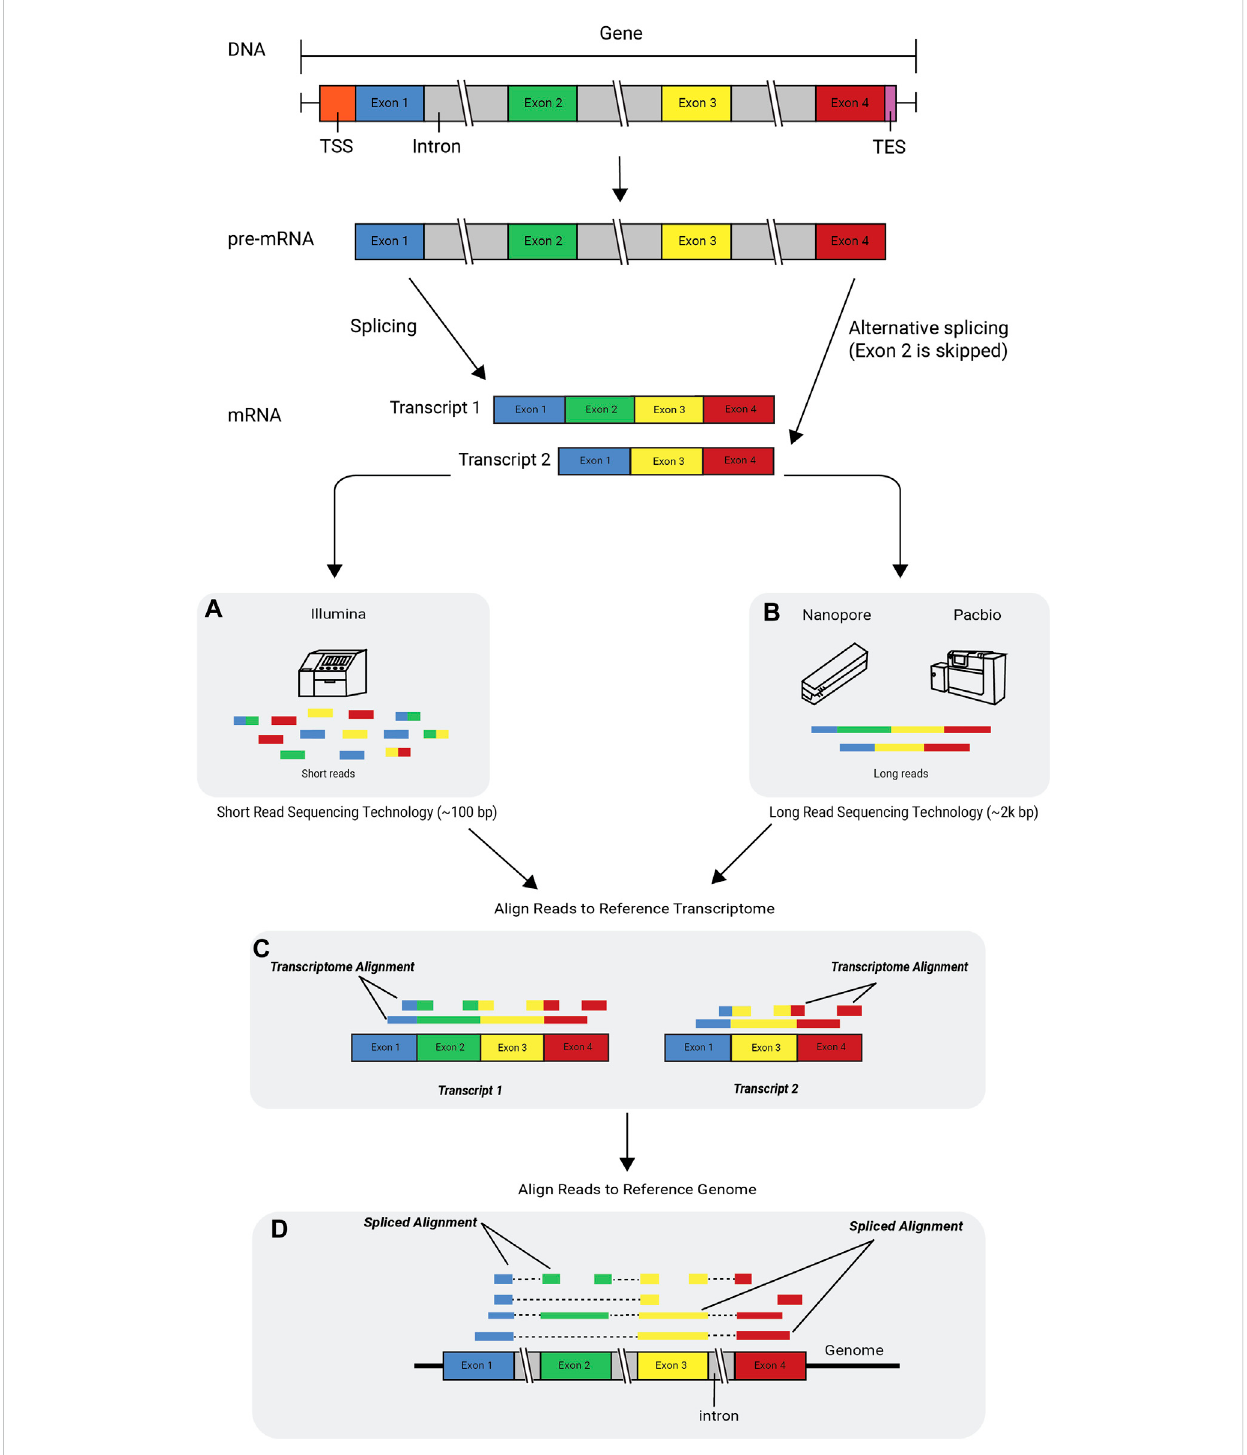
FIGURE 2 Alternativesplicing andRNA-seqtechnologies. The fl ow of geneticinformationbeginswith DNA, whichconsistsof introns and exons. DNA is transcribed into pre-mRNA and then further processed into mature mRNA by splicing out the introns and leaving the exons glued together. The mRNA is then translated into a protein. Transcripts with different arrangements of exons can be formed in a process called alternative splicing or exon skipping. An RNA-seq read is a short sequence sampled from a transcript. Reads are generated using sequencing technologies such as (A) the Illumina platform, which produces short reads, and the (B) Nanopore and PacBio platforms, which produce long reads. The fi gure depicts two scenarios inwhichuniquely mapped reads are aligned to a reference transcriptome (C) anda reference genome (D) , respectively. A few of the reads are multicolored, indicating that when aligned, they span across an exon-exon junction. Some of the shorter reads (single-colored) are aligned only to a single exon and do not span across the junction. TSS , transcription start site; TES , transcription end